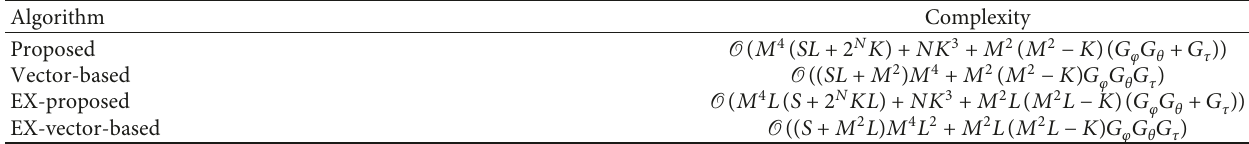
Table 3: Computational complexity comparison.